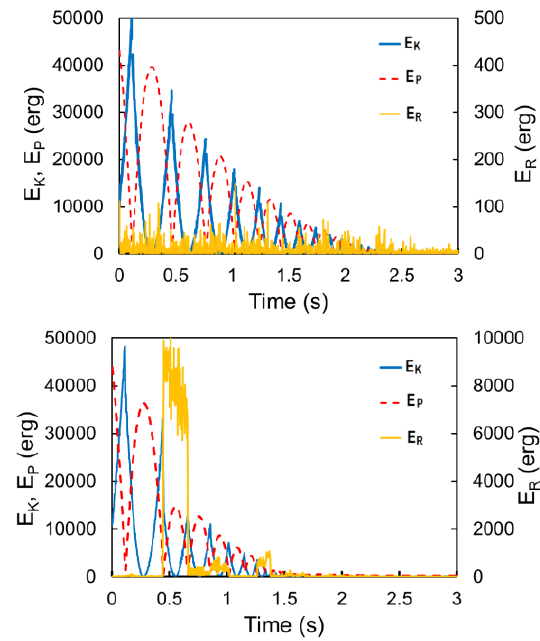
Fig. 4. Example of energy evolution during the relaxation process of a particle: translational kinetic energy (blue solid line), rotational kinetic energy (yellow solid line) and potential energy (red dashed line). Top panel: disk. Bottom panel: faceted